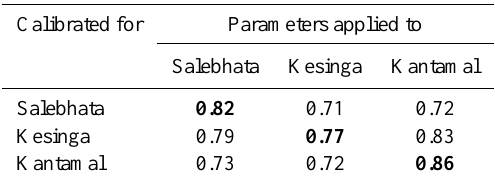
Table 6. Performance of the hydrological model in terms of the Nash–Sutcliffe index (Eq. 4). Calibration results are indicated by bold numbers in the diagonal. Forcing: rain gauge data of the period 2002–2010. Calibrated for Parameters applied to